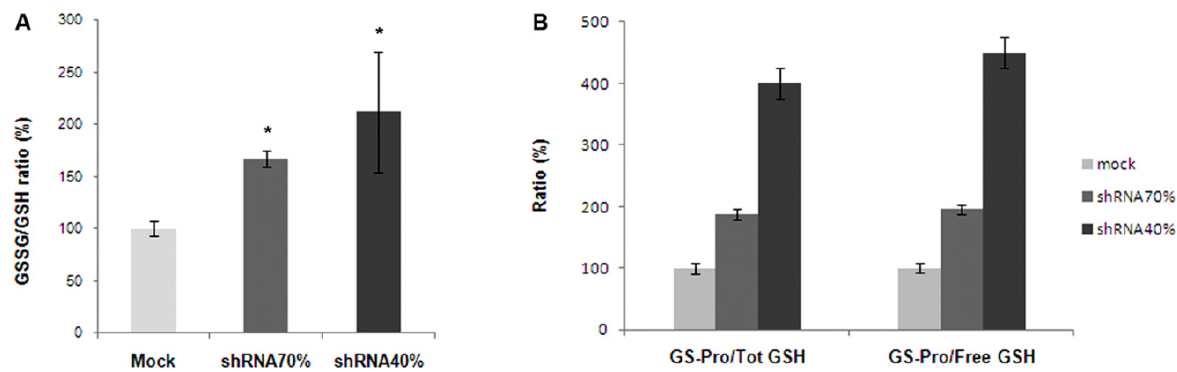
Figure 5. HPLC analysis of glutathione forms in frataxin-silenced NSC34 cells. GSSG/GSH ratio ( A ); and protein-bound (GS-Pro)/total (Tot) GSH and protein-bound/free GSH ratios ( B ) were determined in NSC34, Mock, shRNA 70% and shRNA 40% cells. * p <